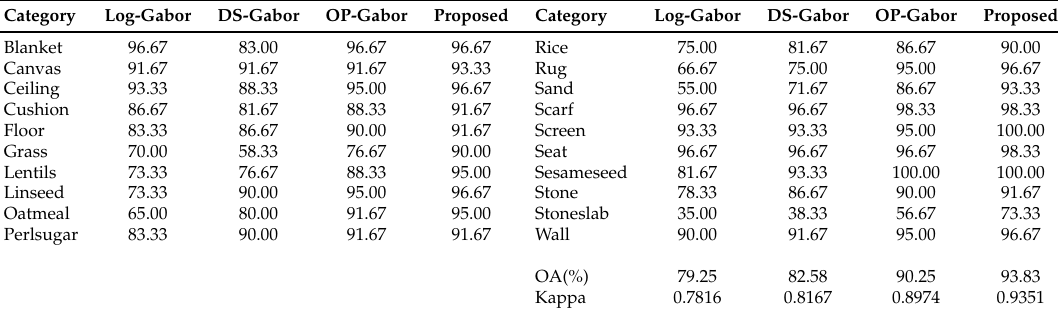
Table 4. Overall classification accuracy and Kappa coefficient for Kylberg